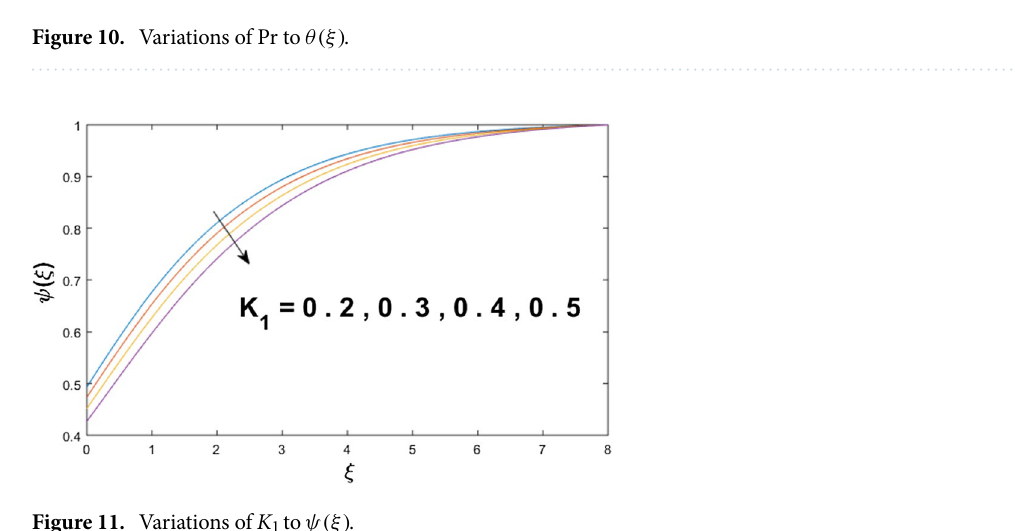
Figure 11. Variations of K 1 to ψ(ξ)